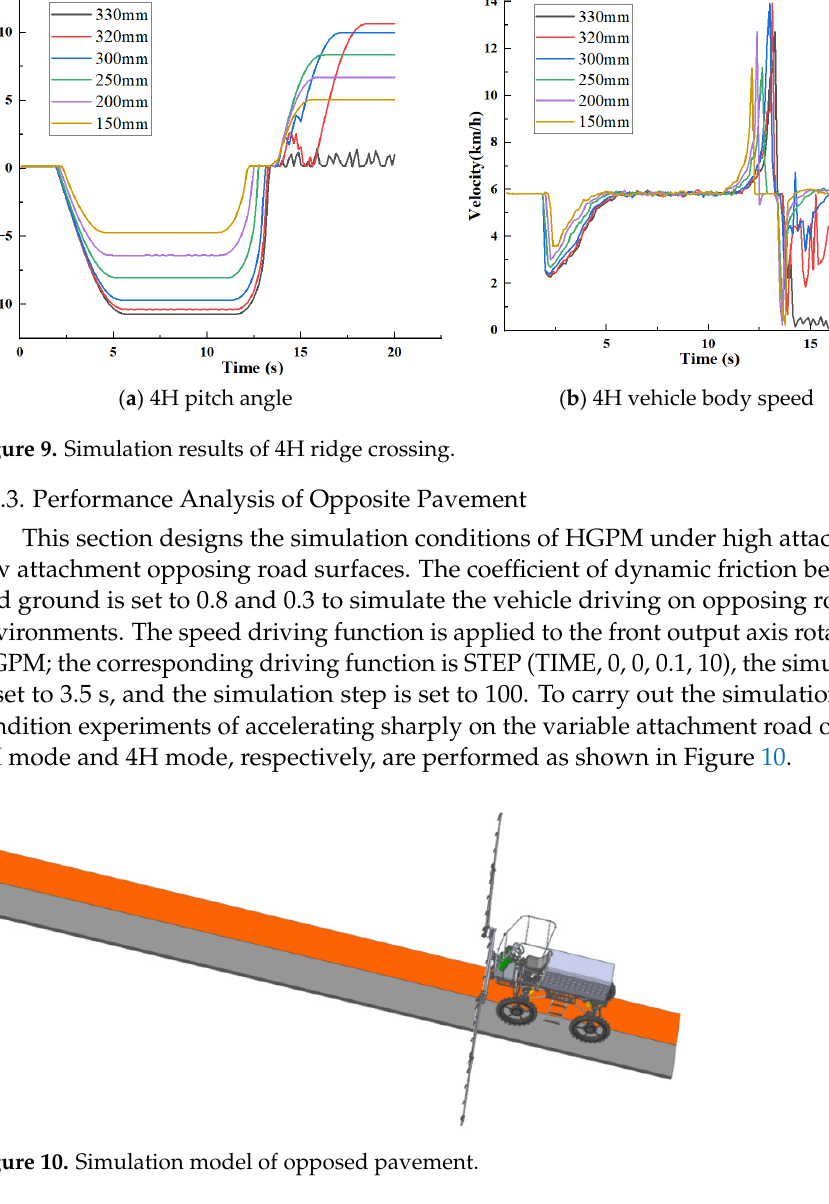
Figure 11. Result of longitudinal vehicle speed simulation. After simulation stabilization, the body speed variation curve under 0 − 4 s upland gap planter chassis over the ridge condition was extracted, as shown in Figure 11. Simu- lation experimental results show that with the 0 − 0.17 s car speed in 2H mode, the acceler- ation is too rapid, and the road surface skids swiftly, resulting in the body speed not in- creasing, but decreasing. In the 0.17 − 0.9 s range, body speed begins to increase to 2.5 km/h faster; in the 0.9 − 4 s range, due to increasing speed, wheel skid intensifies, resulting in slow growth of vehicle driving speed, until the maximum speed of 6.5 km/h. In 4H mode, the 0 − 0.17 s car speed, also due to the rapid acceleration situation, the road surface skids intensely, causing the body speed not to increase but to decrease; in the 0.17 − 0.9 s range, body speed began to increase to 4.9 km/h faster; in the 0.9 − 4 s range, body speed wheel skid intensified due to the increasing speed, resulting in slow growth of vehicle driving speed until the maximum speed of 12.2 km/h. The speed maxima of 2H and 4H modes are 6.5 km/h and 12.2 km/h, respectively, with significant differences in short-time speedups, which indicates that the changes in drive modes of the HGPM have a significant impact on their acceleration characteristics when driving on open roads.